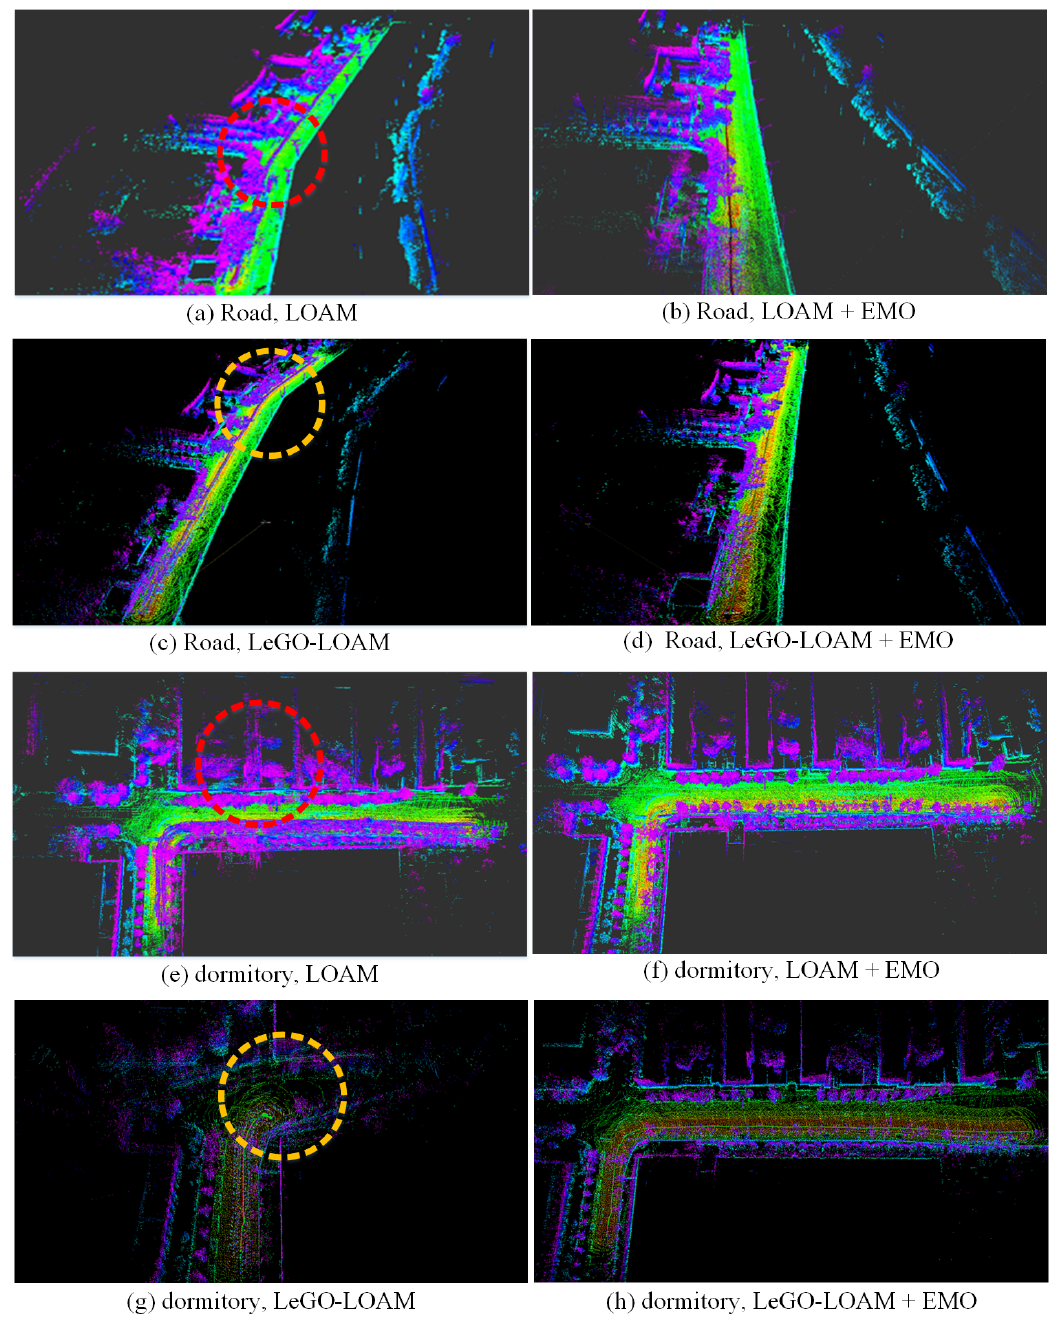
Figure 17. The mapping results (3D view) of dataset road ( a – d ) and dormitory ( e – h ). ( a , c , e , g ) are the maps built by LOAM and LeGO-LOAM before removing dynamic objects, in which the significant mapping errors are marked using circles. ( b , d , f , h ) are the improved mapping results using our method (EMO) of moving object elimination, showing better map consistency and sharper